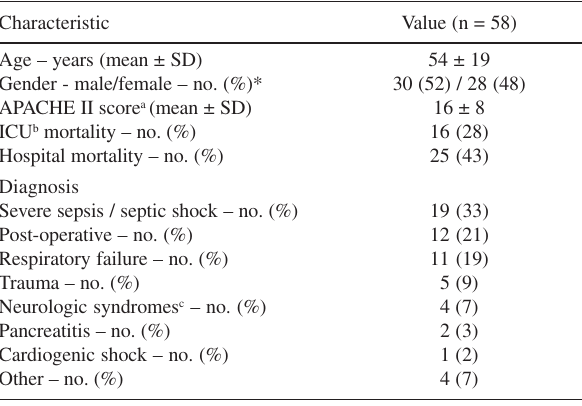
Table 1 - General characteristics of the 58 patients with hyperlactatemia (lactate ≥ 2 mEq/L) Characteristic